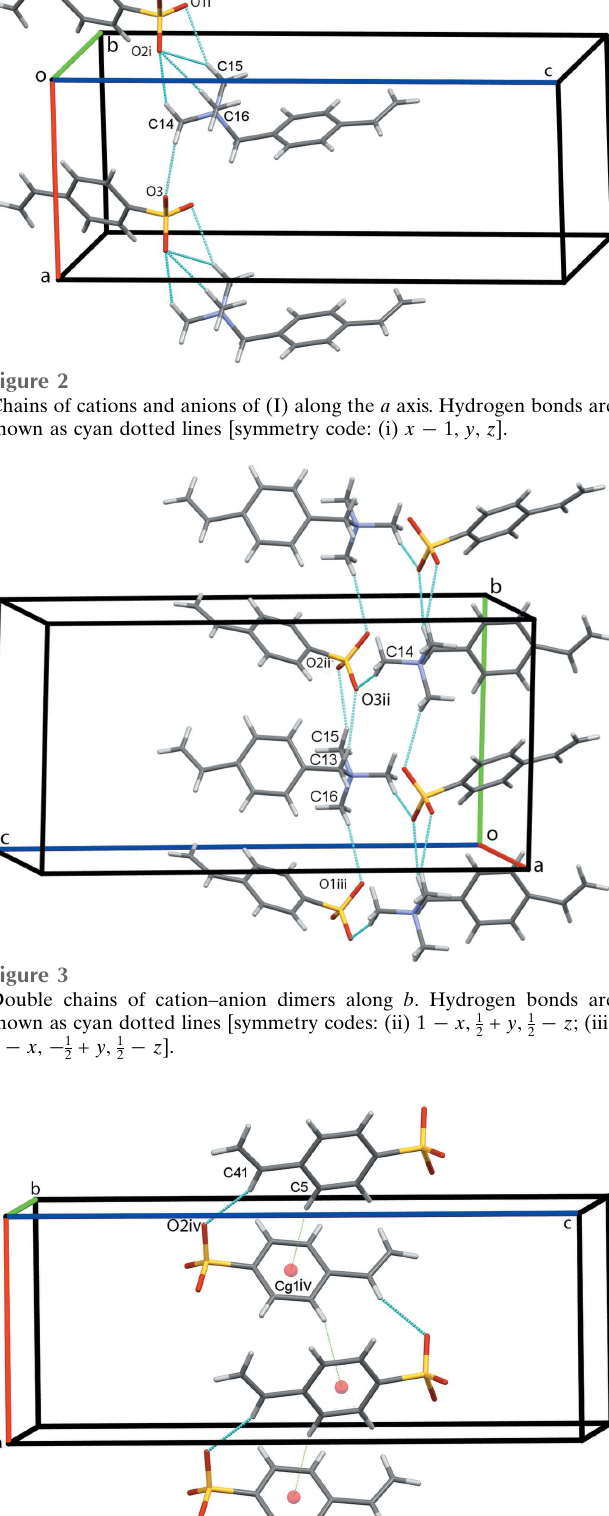
Figure 4 Chains of anions along a . Hydrogen bonds and C—H (cid:2)(cid:2)(cid:2) (cid:2) interactions are shown as cyan and green dotted lines, respectively [symmetry code: (iv) (cid:3) y , (cid:3) z x (cid:3) 1 , 1 2 2